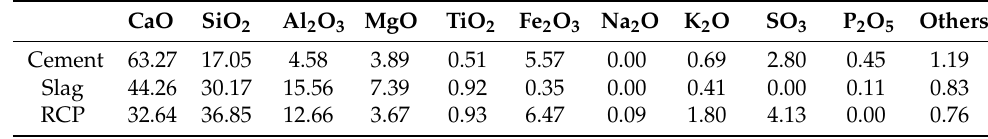
Figure 1. Manufactural progress of RCP. Table 1. Chemical compositions of cement, slag, and RCP, mass %.